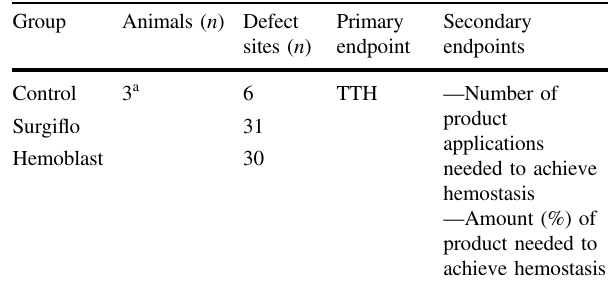
Table 1 Experimental design to test the ef fi cacy of Surgi fl o and Hemoblast in a porcine spleen biopsy punch bleeding model Group Animals ( n )